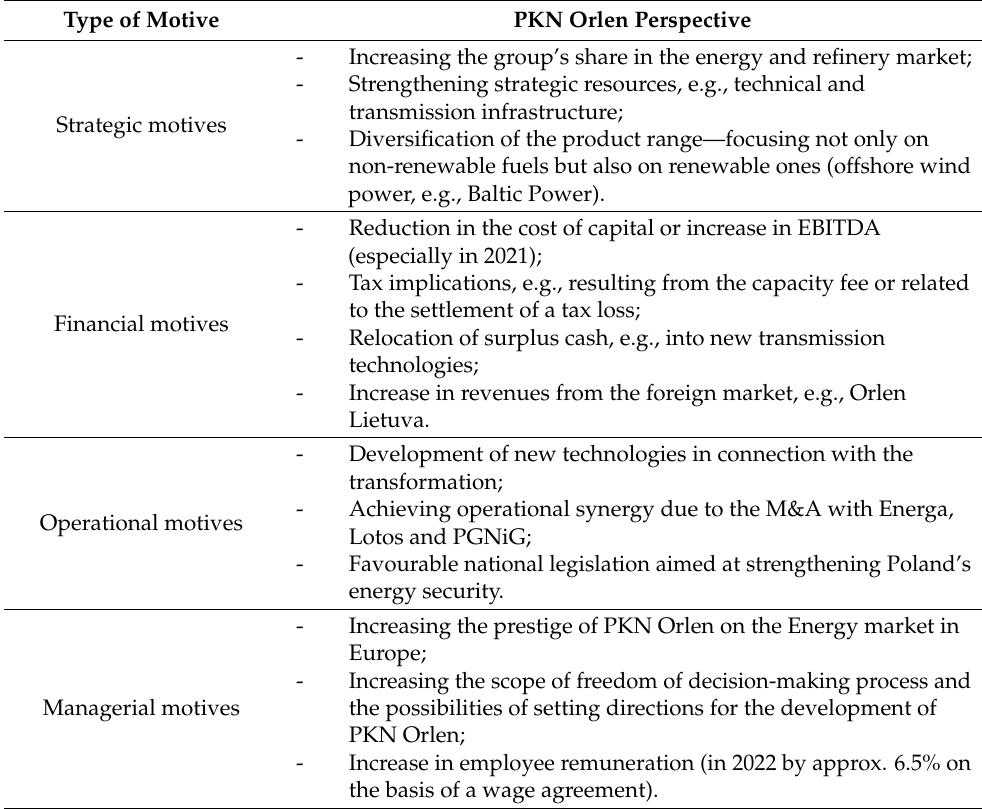
Table 4. Motives of creating the multi-energy concern PKN Orlen, resulting from the mergers and acquisitions carried out by the